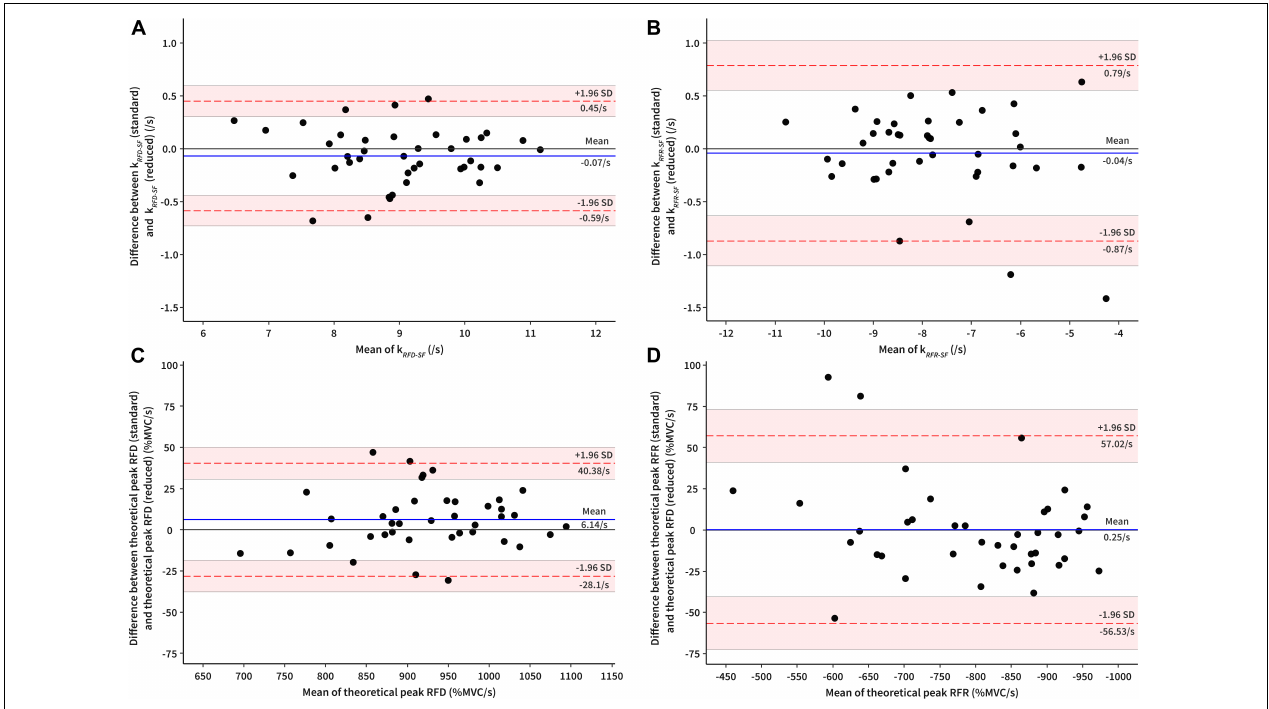
FIGURE 3 | Bland–Altman plots depicting standard and reduced protocol mean values and differences for (A) k RFD − SF , (B) k RFR − SF , (C) theoretical peak rate of force development (TP RFD ), and (D) theoretical peak rate of force relaxation (TP RFR ). The solid line represents the mean bias and the dashed lines represent the limits of agreement for mean bias (shaded area represents 95% confidence intervals of the limits of agreement). k RFD − SF , slope of rate of force development scaling factor; k RFR − SF , slope of rate of force relaxation